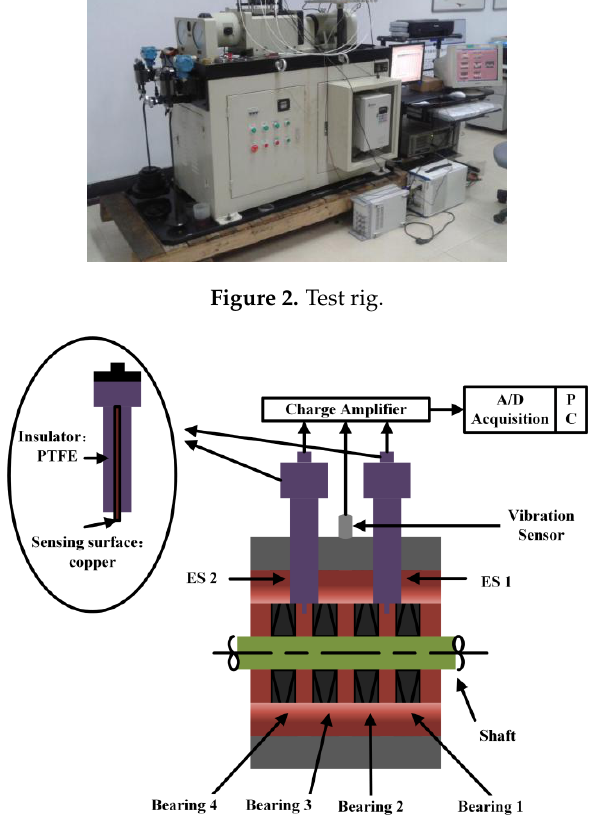
Figure 3. Schematic of the structure of the electrostatic sensor, the mounting position of monitoring sensors and the acquisition systems.